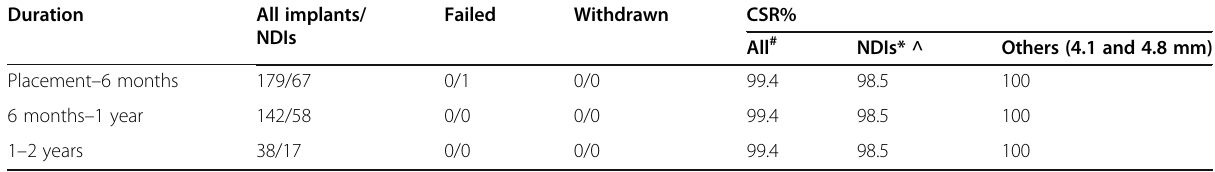
Table 2 Cumulative survival rates (CSR) for implants (total/narrow) inserted Duration All implants/ Failed NDIs